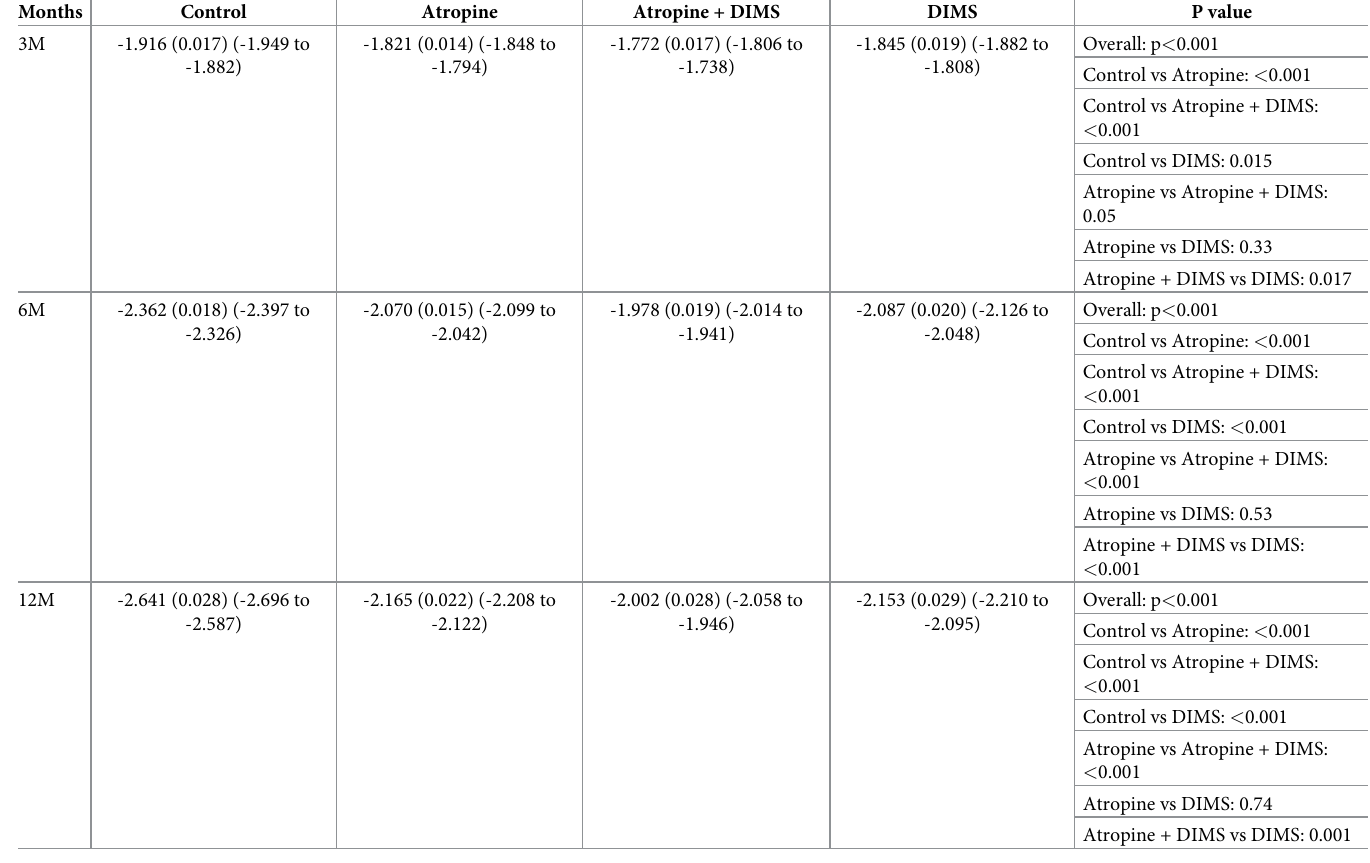
Table 3. Treatment effect over time on